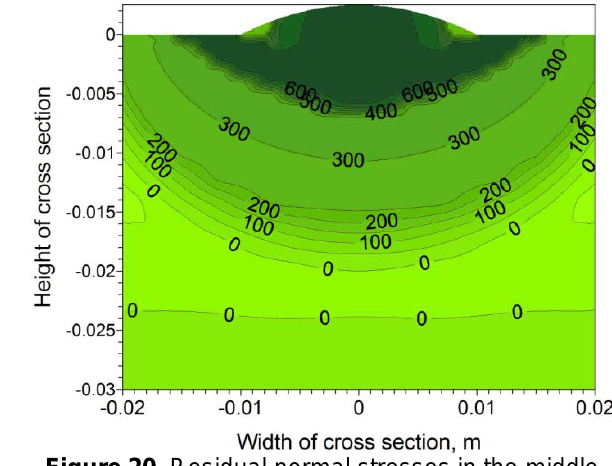
Figure 20. Residual normal stresses in the middle part-area of cross section of plate